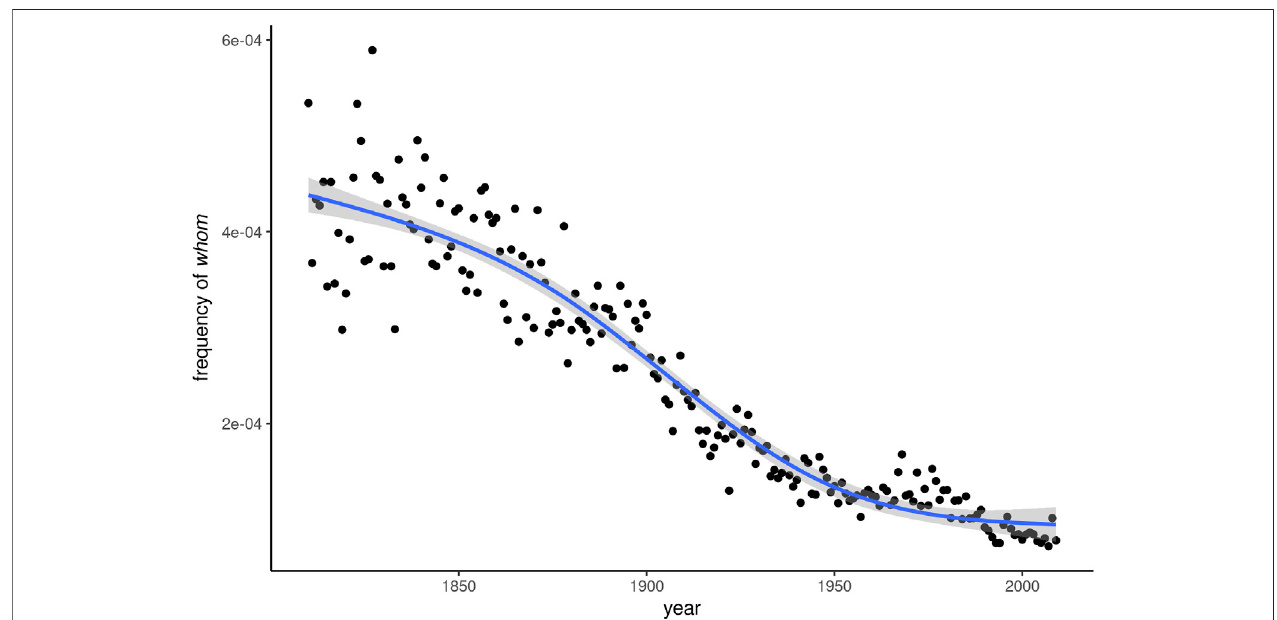
FIGURE 1 | Frequency development of whom over 180 years of written American